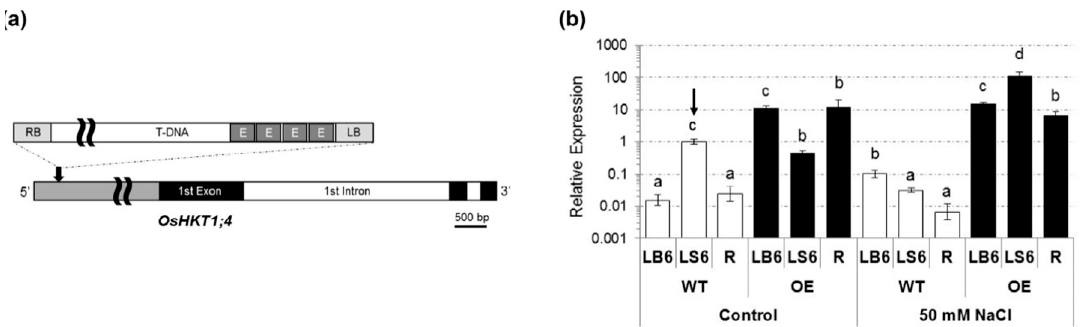
Figure 1. Isolation of a T-DNA insertion mutant rice line that overexpresses the OsHKT1 ; 4 gene, driven by enhancer elements in the T-DNA. ( a ) A schematic diagram of the T-DNA mutant allele used in this study, PFG_3A-05753.L. A grey box in the OsHKT1 ; 4 gene represents the promoter region, and exons and introns are indicated as black and white boxes, respectively. An arrow represents the insertion site of the T-DNA. Gray boxes with the word E in the T-DNA represent the enhancer element region, which is consisted of four tandem repeats of the core sequence of the 35S promoter. Note that the T-DNA insertion site is located at approximately 3 kb upstream from the first ATG of OsHKT1 ; 4 ; ( b ) results of qPCR on the expression of OsHKT1 ; 4 in the 6th leaves and roots of the homozygous insertion line (O/E) and its sibling WT (WT). Approximately 3-week-old plants were prepared by hydroponic culture and 50 mM NaCl was imposed for 3 days prior to the experiment. The transcript level of OsHKT1 ; 4 and an internal control OsSMT3 was analyzed. Relative expression of OsHKT1 ; 4 is shown with a logarithmic scale setting its expression in the 6th leaf sheath of WT from the control condition to 1 ( n = 4, ± SD). LB6, LS6 and R represent, respectively, 6th leaf blades, 6th leaf sheaths, and roots. Different alphabets represent significant differences at the level of 5% (Tukey’s test).